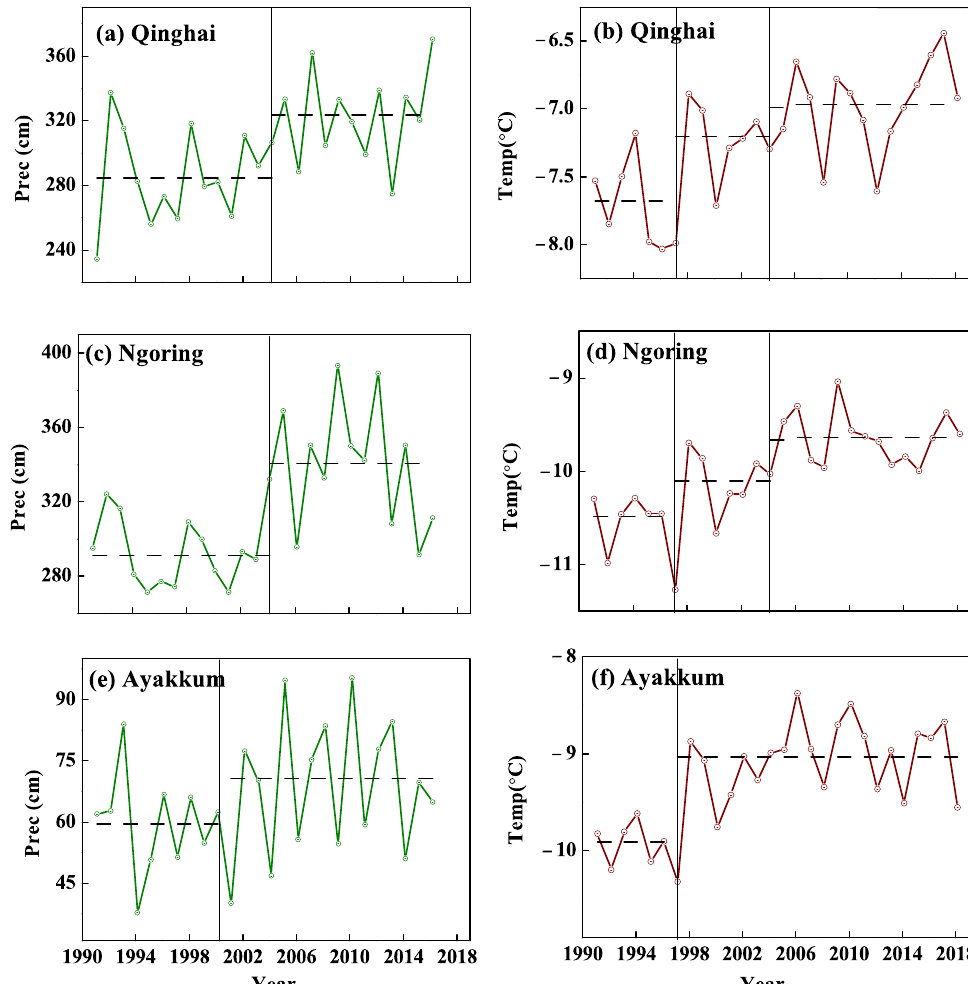
Figure 6. The significant regime shift in time series of precipitation (green line, left panel) and temperature (red line, right panel) over three lakes in the northern part of the Tibetan Plateau: vertical lines represent regime shift years and horizontal dash lines represent the mean value of each regime.